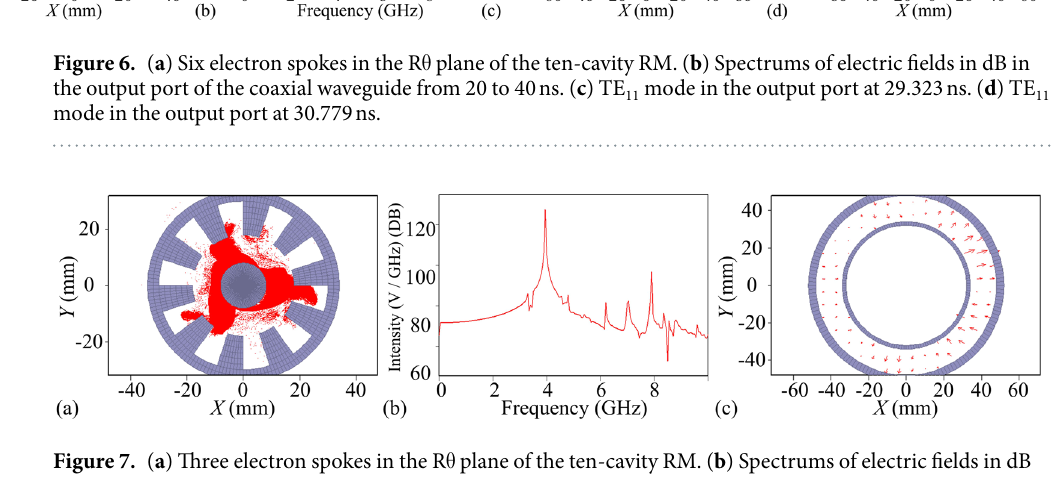
Figure 7. ( a ) Three electron spokes in the R θ plane of the ten-cavity RM. ( b ) Spectrums of electric fields in dB in the output port of the coaxial waveguide from 20 to 40 ns. ( c ) Mixed modes in the output port.